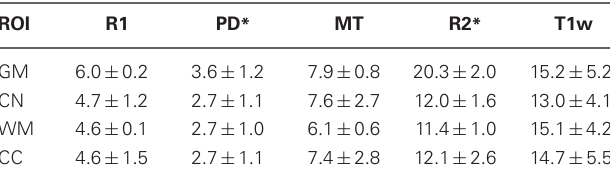
FIGURE 3 | Inter-site coefficient of variation (CoV) of R1, PD ∗ , MT, and R2 ∗ parameter maps and T1w images intensity values. Values were determined separately for gray matter (GM), head of the caudate nucleus (CN), white matter (WM), and genu of the corpus callosum (CC). For explanation of the whisker plot, see Figure 2 . Table 2 | Group mean and standard deviation of the inter-site coefficient of variation (CoV) in percent for the parameter values and T1w image intensity in different